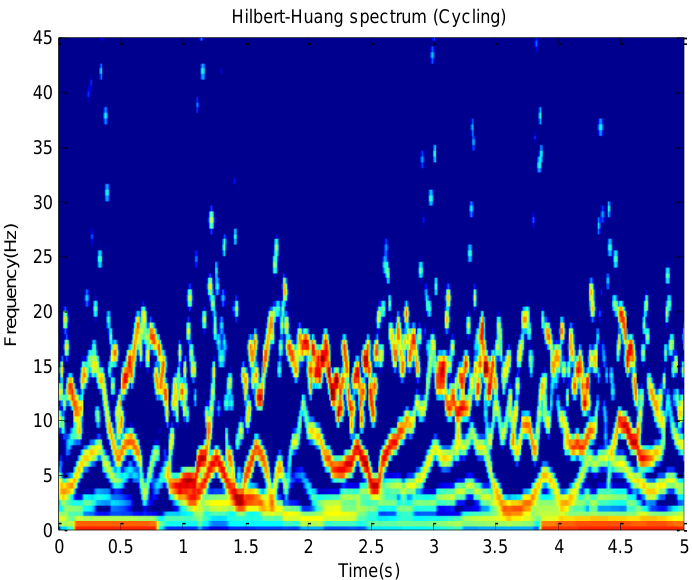
Figure 4. The Hilbert-Huang spectrum for the cycling data with 100 Hz frequency. The energy distribution of skeleton lines gives a better comparison with other types of activities. The Hilbert-Huang spectrum was filtered by a 9 × 9 weighted Gaussian